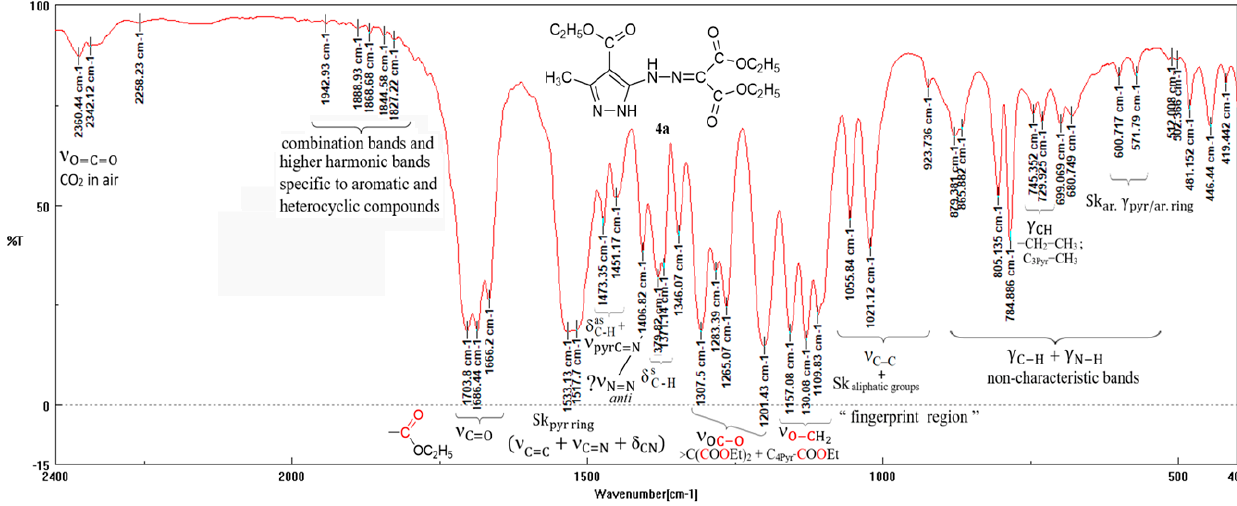
Figure 2. Enlarged (2400–400cm − 1 ) FT-IR spectrum of 4a